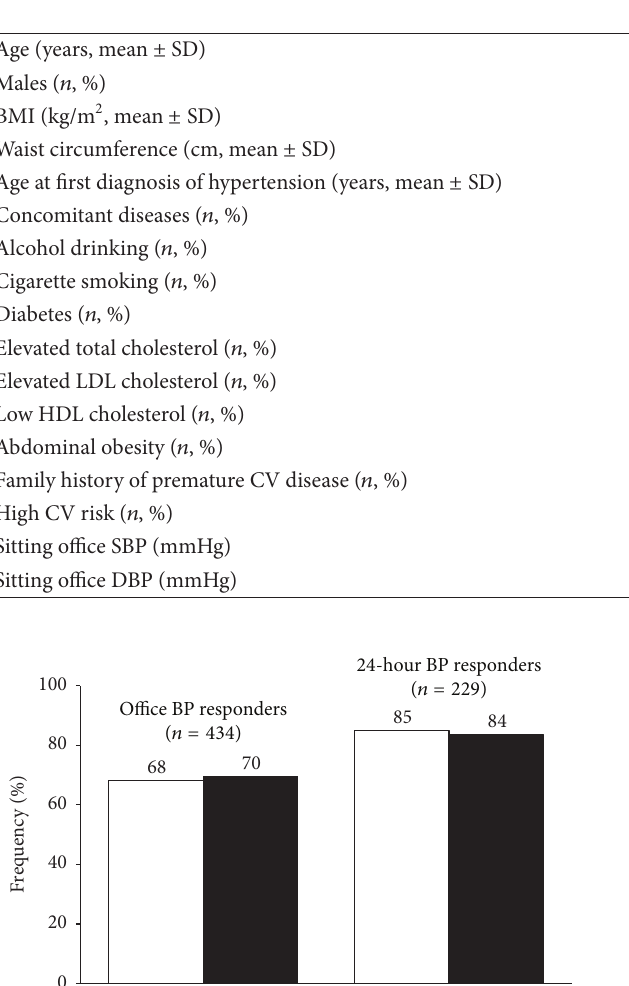
Figure 2: Percentage (%) of office blood pressure (BP) responders ( < 140/90mmHg in nondiabetics and < 130/80mmHg in diabetics or high-risk patients, or SBP reduction ≥ 20 mmHg or DBP reduction ≥ 10mm) and of 24-hour BP responders ( < 130/80 mmHg or a SBP reduction ≥ 10 mmHg or a DBP reduction ≥ 5 mmHg) after 18 weeks of treatment with zofenopril 30–60 mg plus hydrochlorothiazide 12.5 mg (open bars) and irbesartan 150–300 mg plus hydrochloroth- iazide 12.5 mg (full bars). Data are shown for the intention-to-treat population ( 𝑛 = 434 office BP set; 𝑛 = 229 ambulatory BP